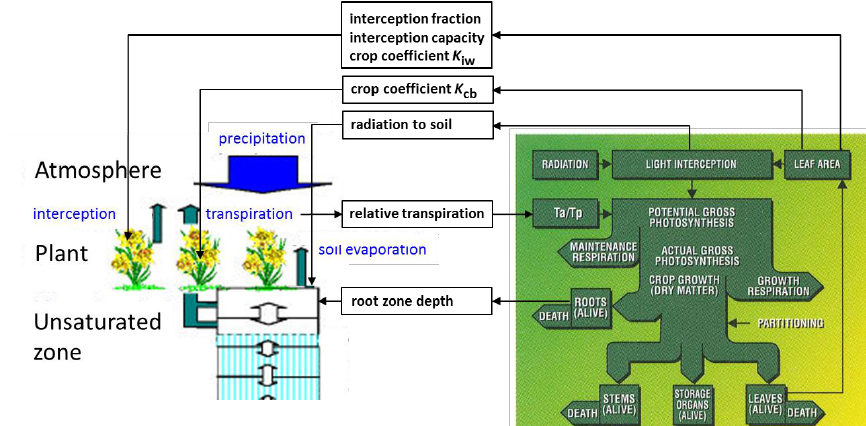
Figure 3. Coupling MetaSWAP-WOFOST as implemented in the SIMGRO modelling 2 Fig. 3. Coupling MetaSWAP-WOFOST as implemented in the SIMGRO modelling